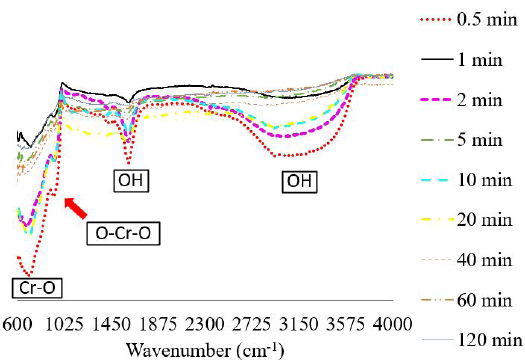
Figure 1. Absorptance spectroscopy in the UV-Vis-NIR range of the produced films.